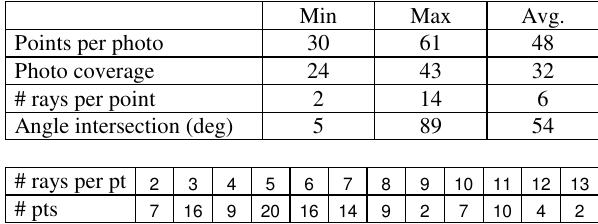
Table 2. Myson, manual orientation: block strength statistics